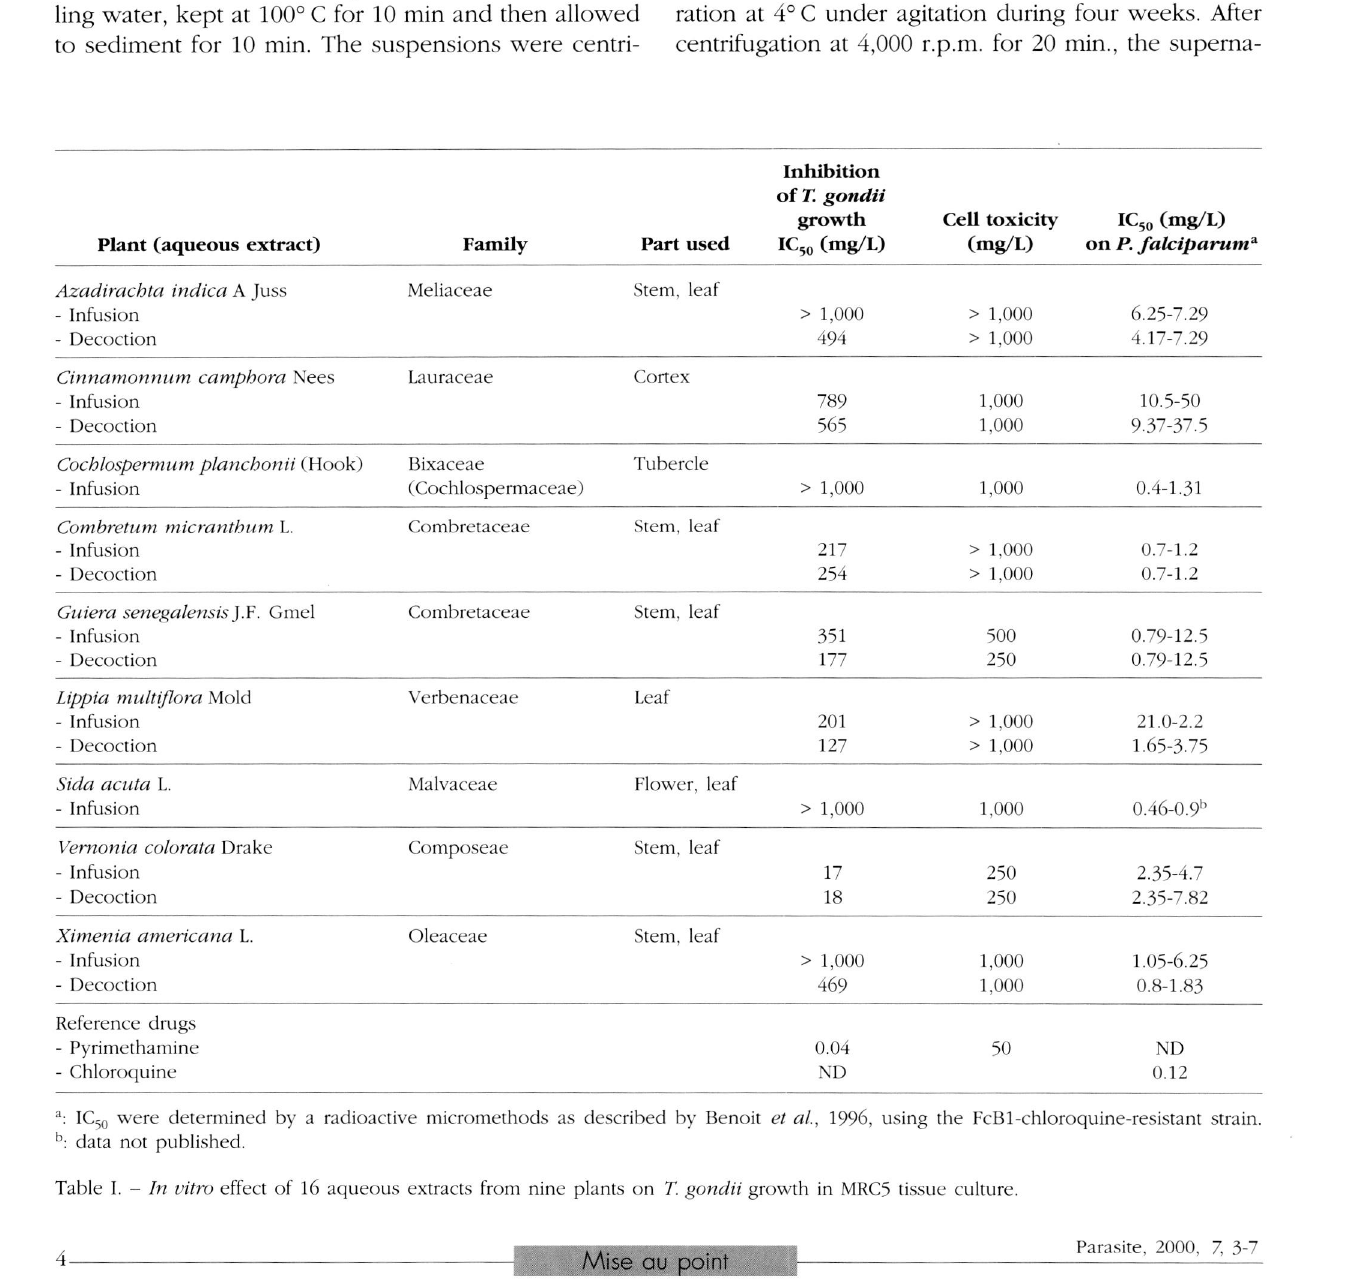
Table I. - In vitro effect of 16 aqueous extracts from nine plants on T. gondii growth in MRC5 tissue